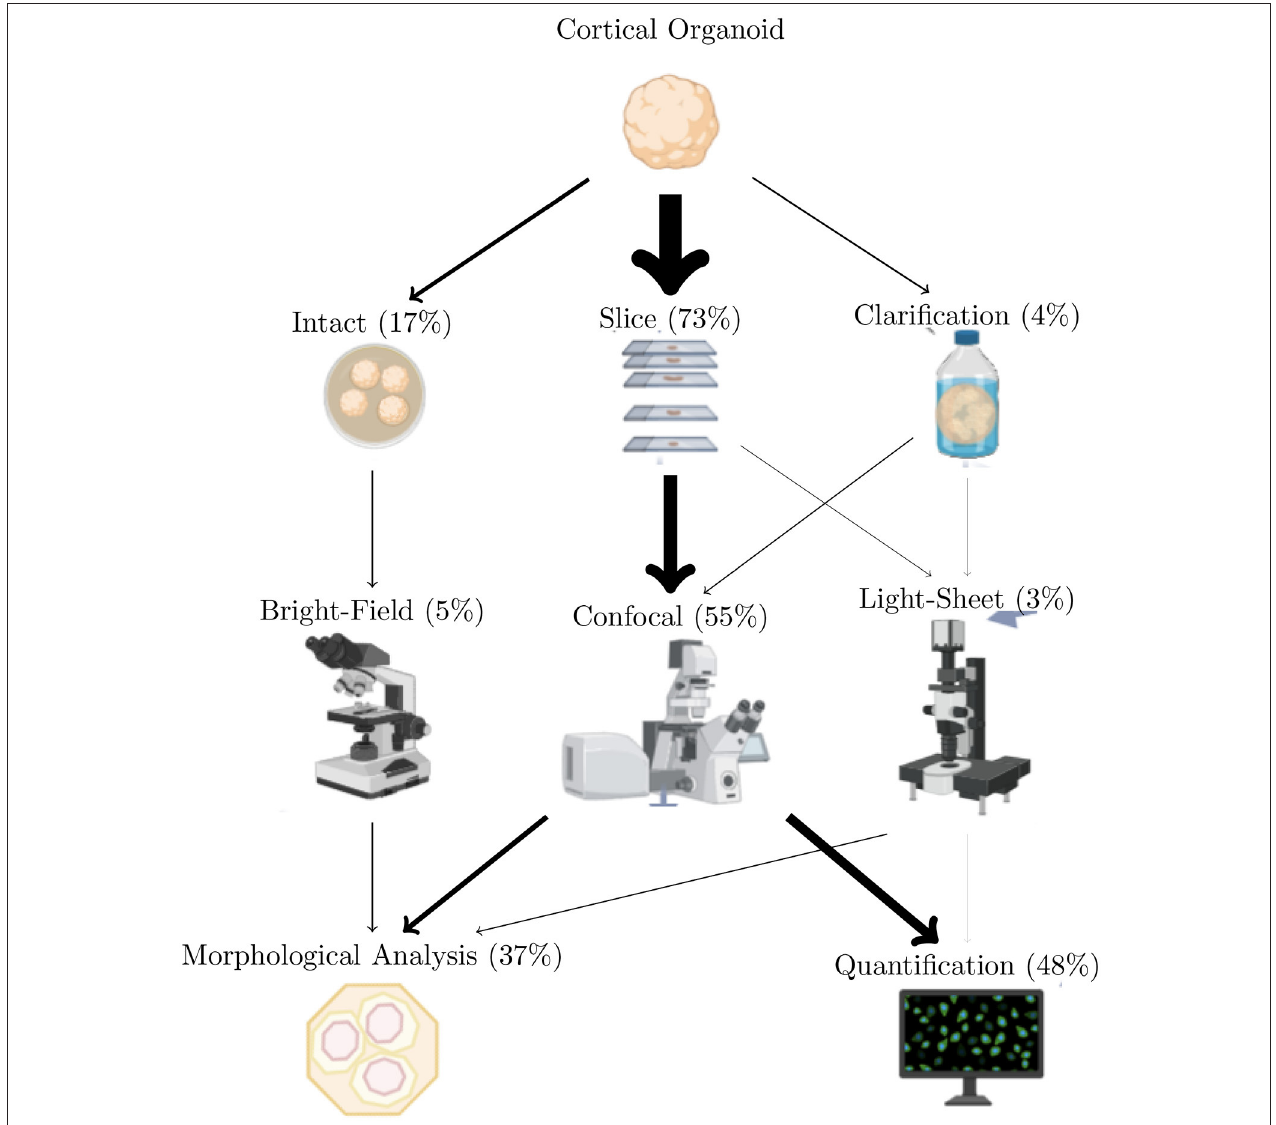
FIGURE 5 | Imaging techniques most used to study cerebral organoids. Arrows width is proportional to use of the methods over the reviewed articles. Totals are less than 100% since only the most used methods are included in this figure. Also, a given article can describe multiple analyze